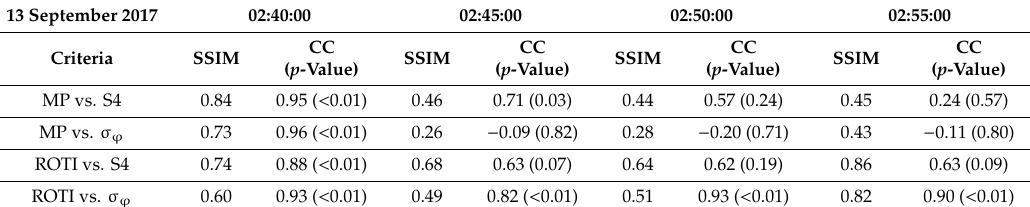
Table 11. SSIM and CC between the maps shown in Figure 10.